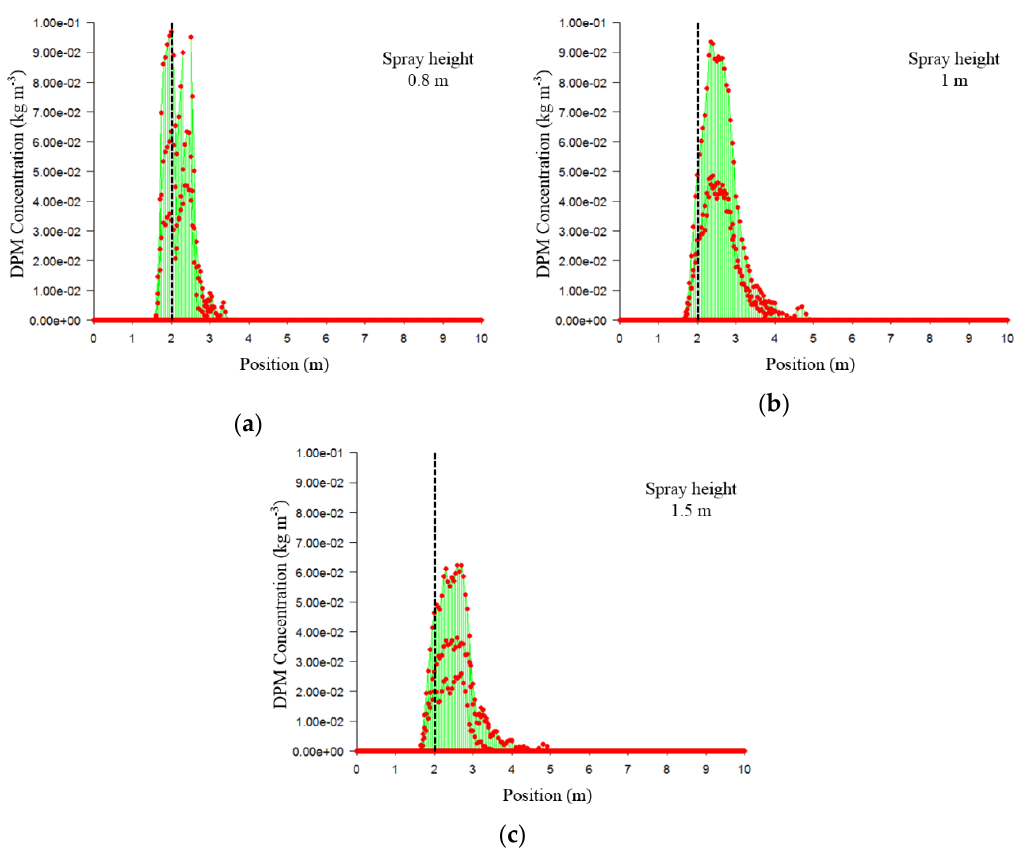
Figure 9. Concentration of droplets deposition in different spray heights, ( a ) 0.8 m, ( b ) 1 m, and ( c ) 1.5 m. X-axis means different position of target area and off-target area, Y-axis means DPM Concentration (kg m − 3 ) of droplets deposition in different spray height, 0.8 m, 1 m, and 1.5 m. The point means concentration of different position, the dotted line means the droplet concentration deposition center and the solid line means the biggest concentration of corresponding point.